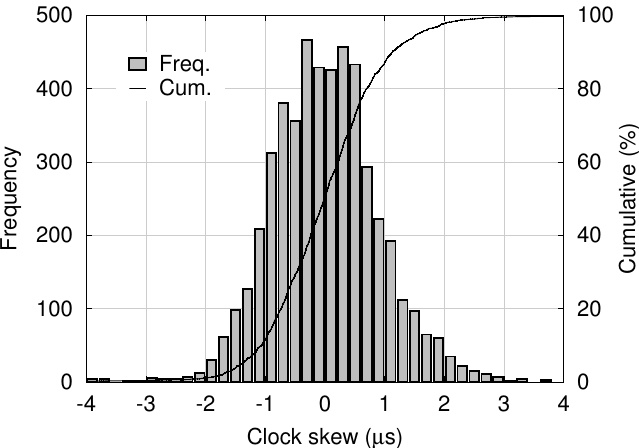
Figure 9. Distribution of clock skew of the slave with respect to the master.